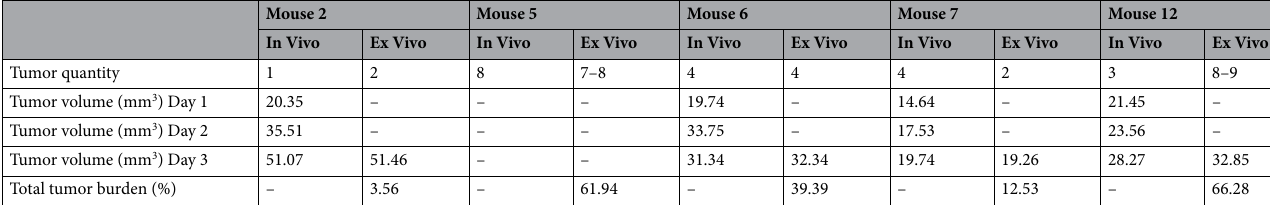
Table 2. Tumor quantity and volume measured from in vivo and ex vivo micro-CT images for the five mice injected with Fenestra VC. The quantity was measured by counting individual tumors in the liver. The tumor volume is measured in the in vivo and ex vivo images.